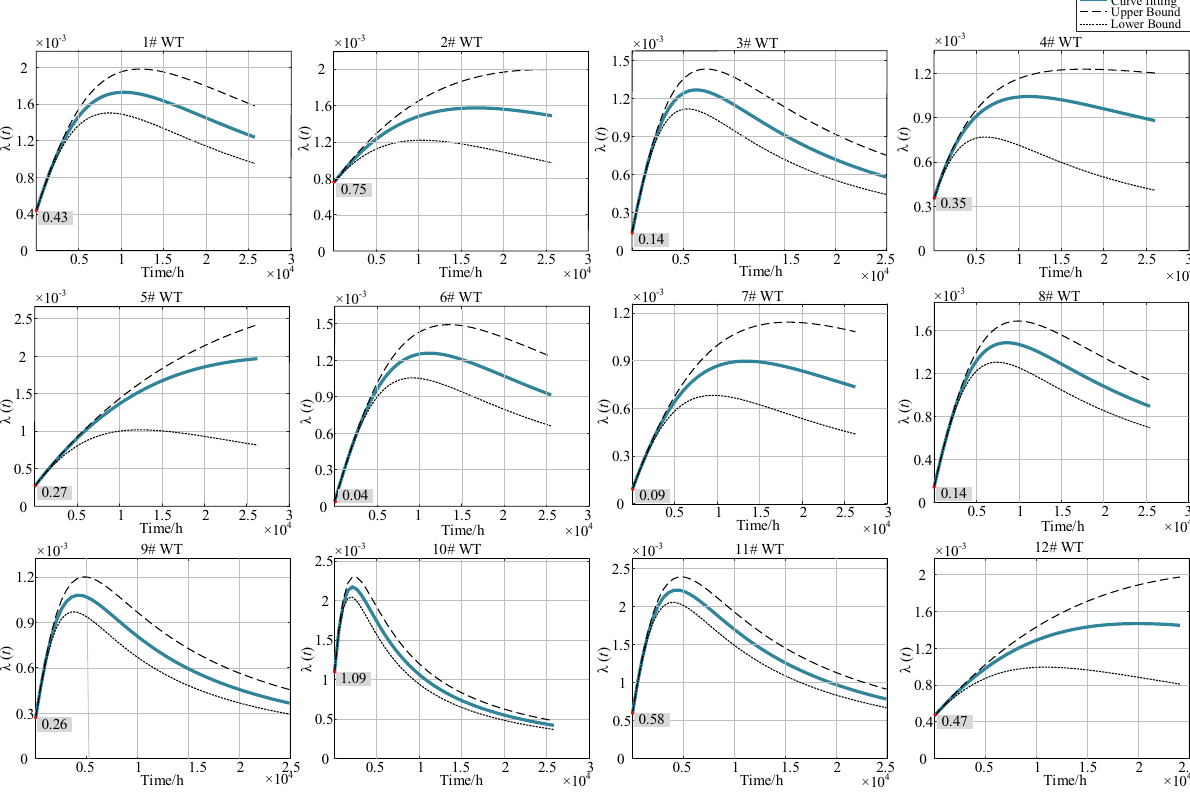
Figure 2. Results of fitting the instantaneous failure intensity function.